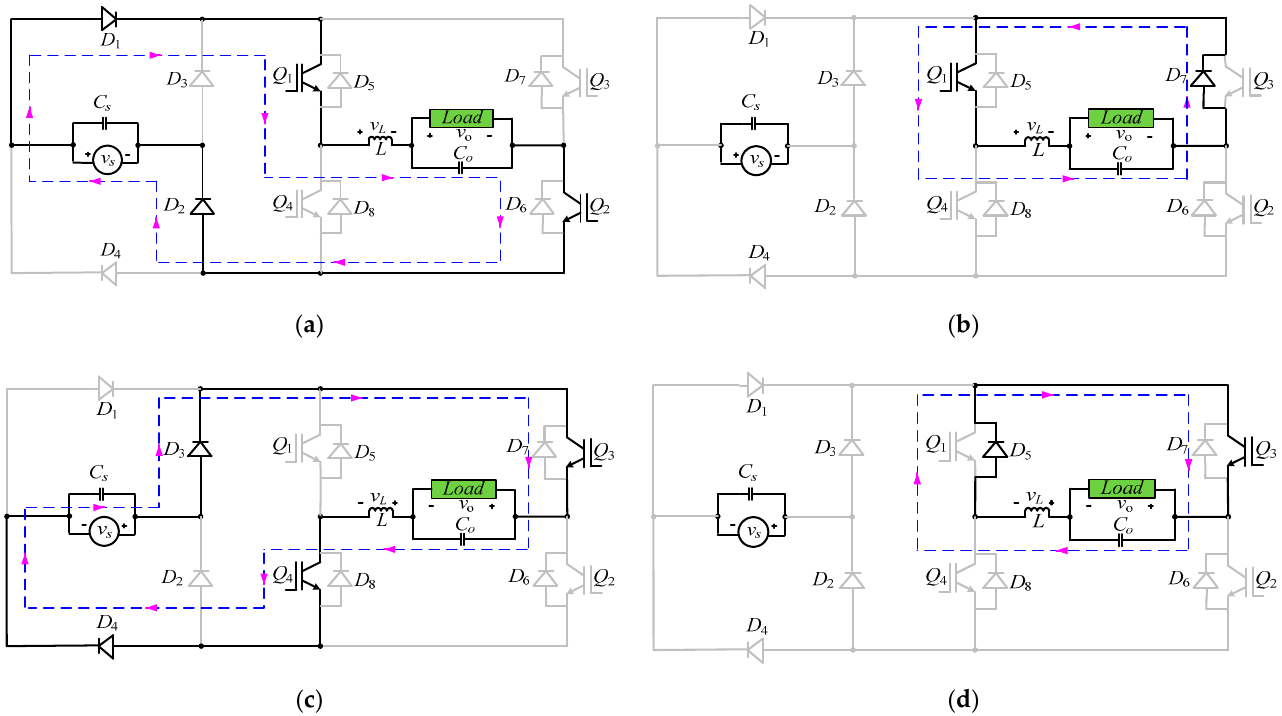
Figure 4. Equivalent power transfer circuits for non-inverting voltage buck operation: ( a , b ) for mode I and ( c , d ) for mode II.